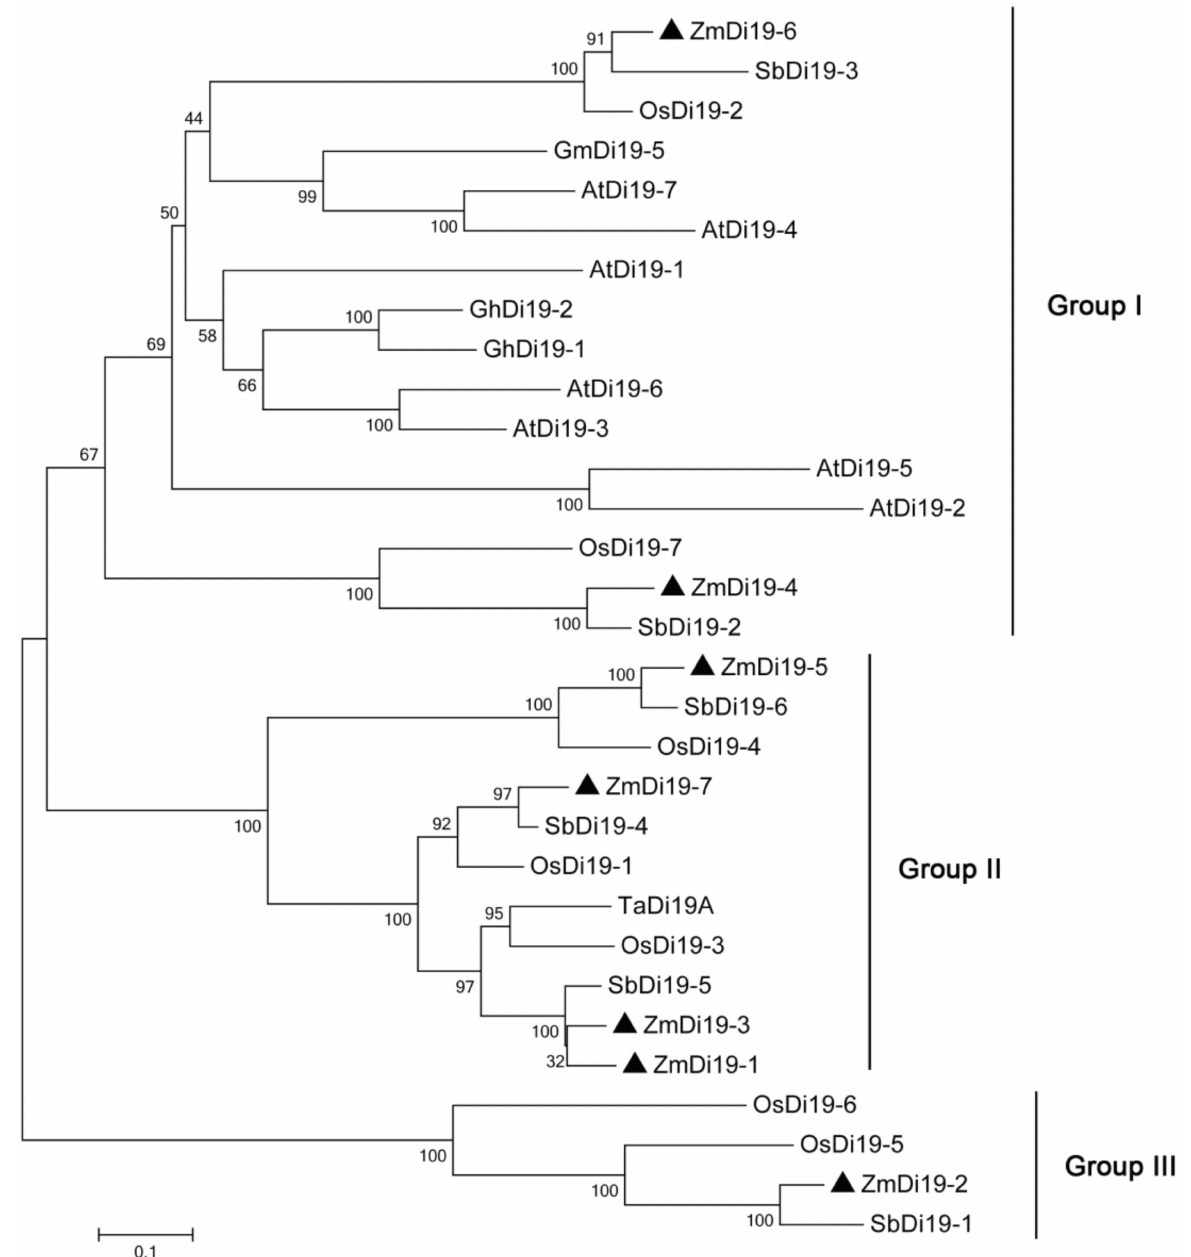
Figure 4. Phylogenetic tree of Di19 proteins from maize, rice, Arabidopsis, and other